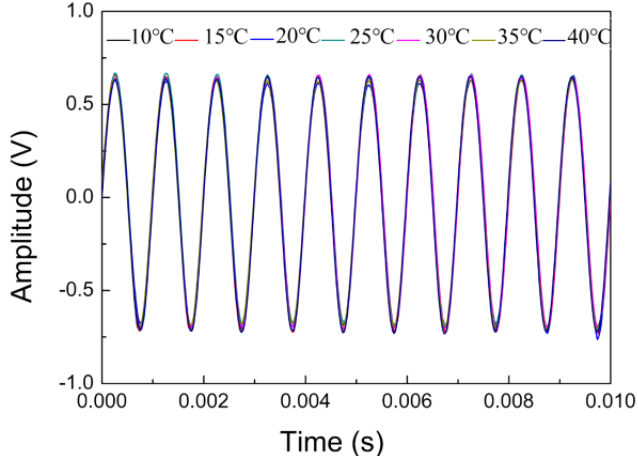
Figure 6. Temporal responses of the fiber-optic microphone to 1 kHz sound measured at different temperatures.